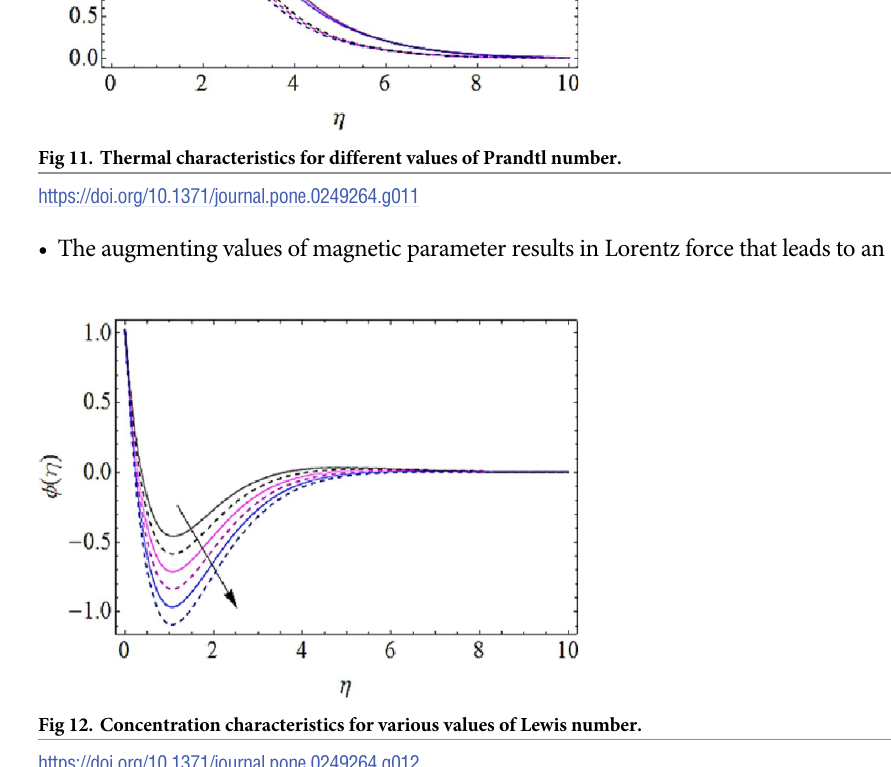
tation of thermal boundary layer thickness which augments the temperature of flow system.